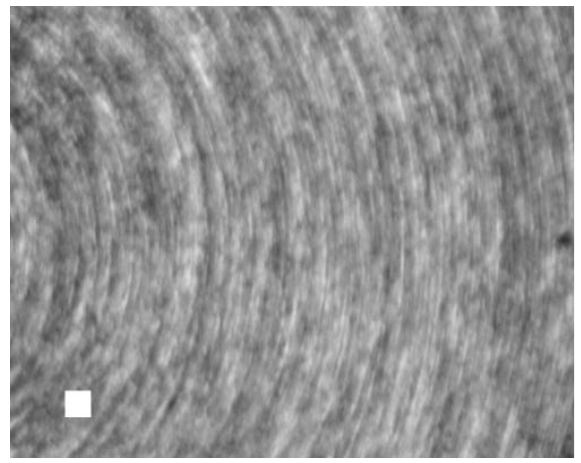
FIG. 5. Photograph of the scandate dispenser cathode sur- face. Concentric rings are evident from machining. The white square in the lower left corner corresponds to a 0 : 1 mm (cid:7) 0 : 1 mm area.